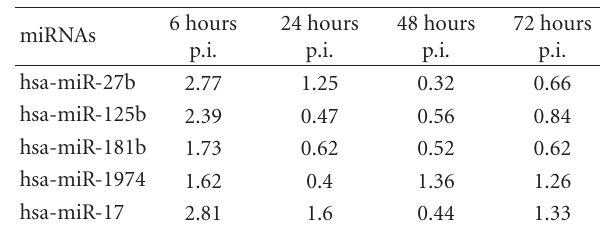
Table 4: The ratio of ADV-3 infected cells/control cells at di ff erent time course after the